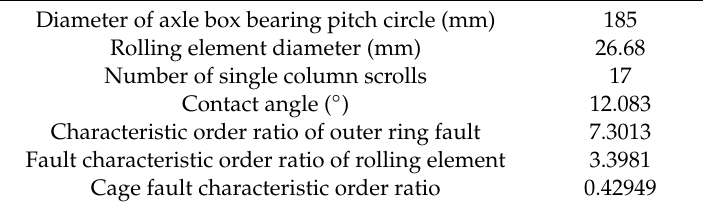
Table 4. Dimension and fault characteristic parameters table of the axle box bearing.